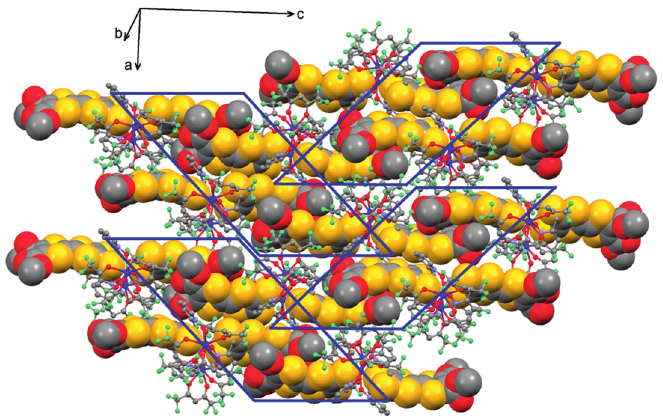
Figure 2. Crystal packing of 1 highlighting the formation of tetramers of L through short S···S and S···O contacts. Colour code: grey (C), red (O), orange (S), blue (D), green (F).